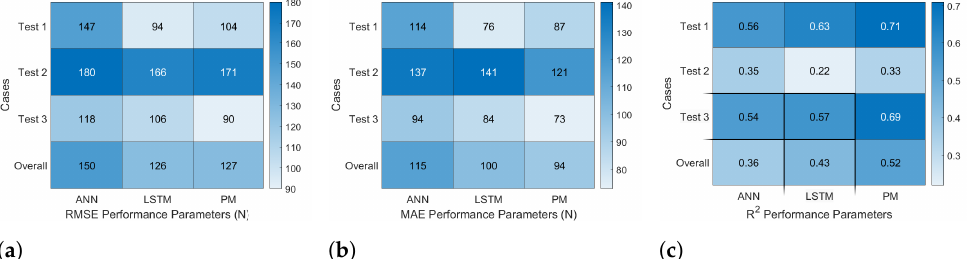
Figure 23. Performance analysis of PM, ANN, and LSTM models under steady wind conditions: